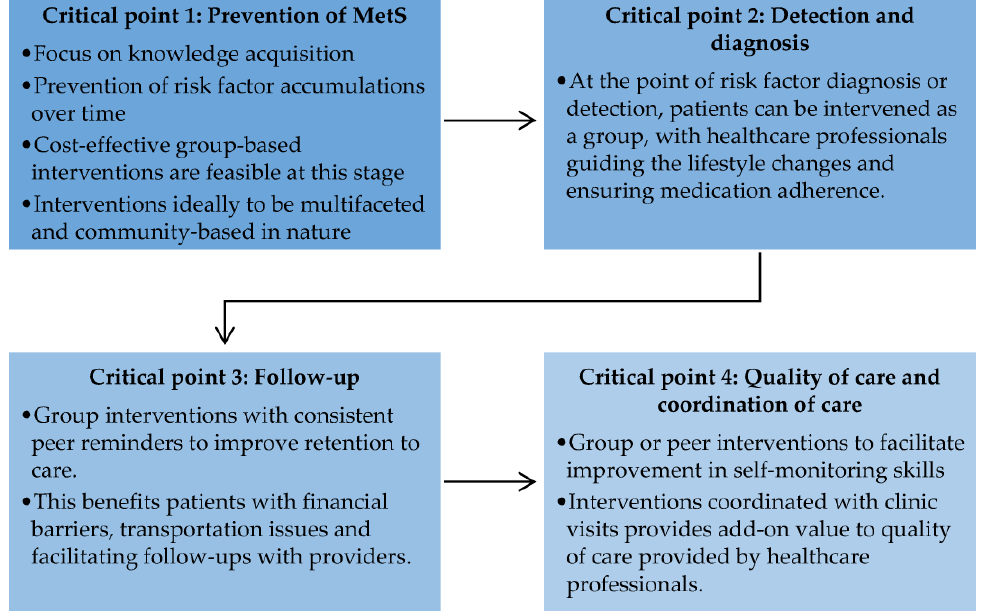
Figure 3. Critical points for future research in the prevention and management of metabolic syn- drome.